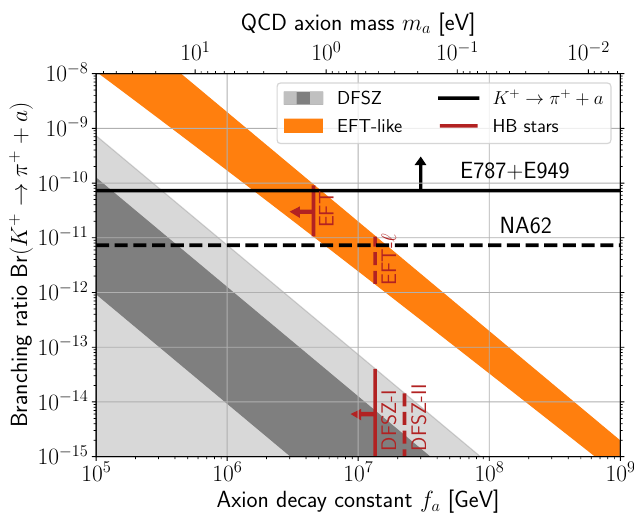
Figure 5 . Comparison of the branching ratio of K + → π + + a predicted in the EFT-like model (orange band) and in the DFSZ model (grey bands). For the EFT-like model, we assume a universal quark coupling c q = 1 / 6 and different values of the cutoff scale Λ (between 30 f a and M Pl as discussed in the text). The DFSZ bands are obtained for a charged Higgs boson mass m 1 < tan β < 5 (darker band) or 0 . 25 < tan β < 170 (lighter band). The horizontal black lines show the existing constraint by the E787 and E949 experiments [116] (solid line) and the expected reach of NA62 [117] (dashed line). The vertical red lines describe the bounds set by HB stars,